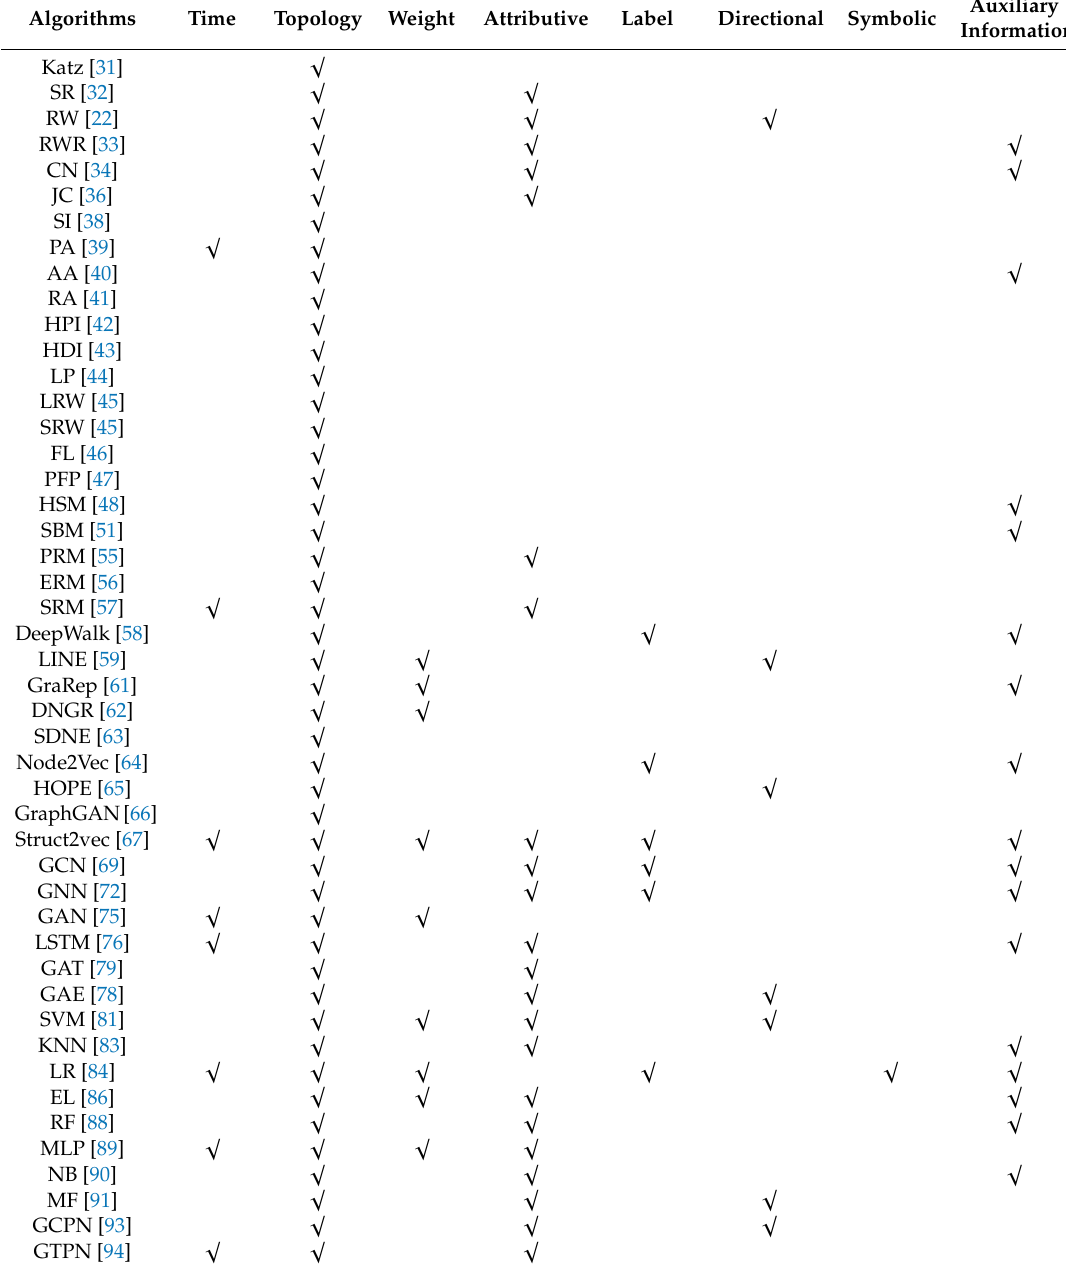
Table 1. The input features of common link prediction methods are